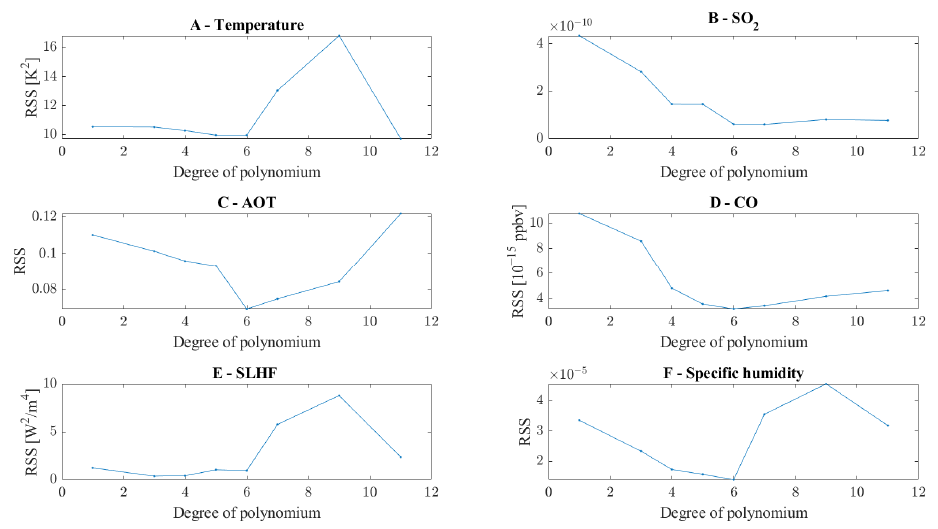
Figure 4. Residual Sum of Square (RSS) of the polynomial fits using different degrees from 1 to 11 applied to atmospheric time series of Temperature ( A ), SO 2 ( B ), aerosol ( C ), CO ( D ) surface latent energy flux ( E ), and specific humidity ( F ).